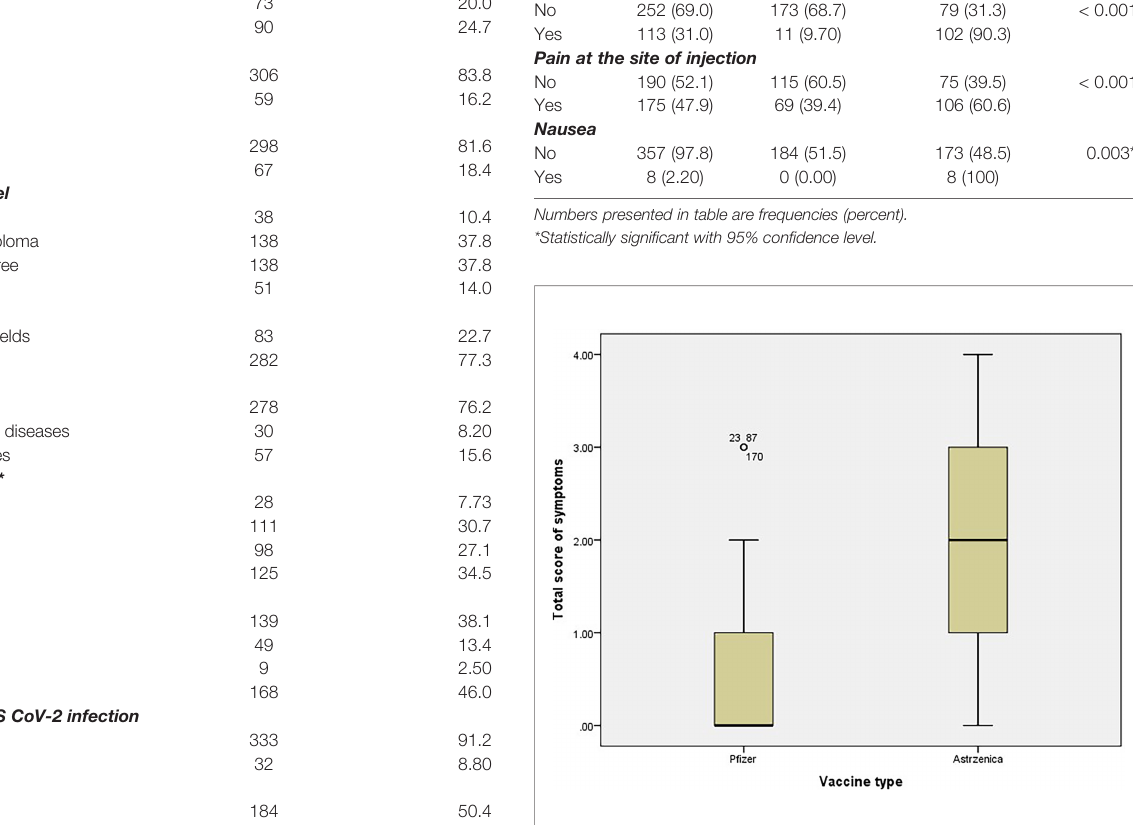
FIGURE 2 | Total score of vaccine-related symptoms among participants who received P fi zer and AstraZeneca vaccines (n=